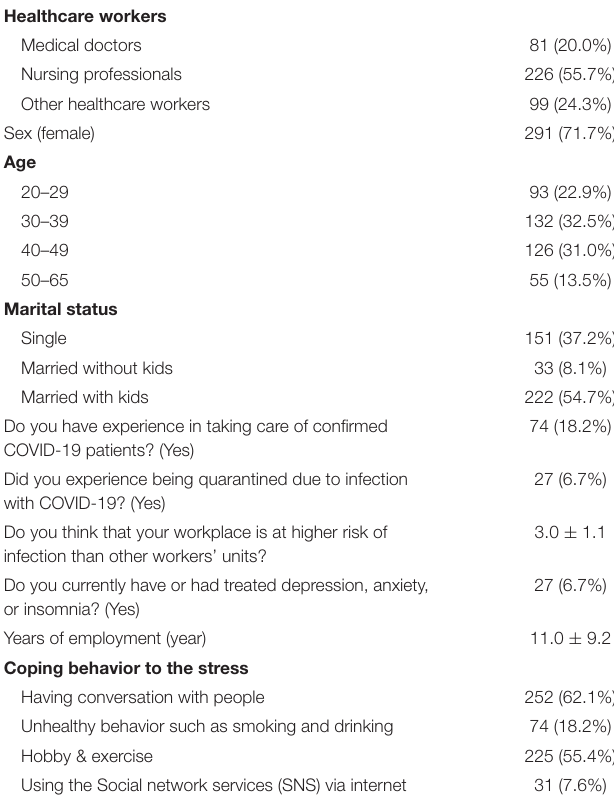
TABLE 1 | Demographic characteristics of subjects ( N =